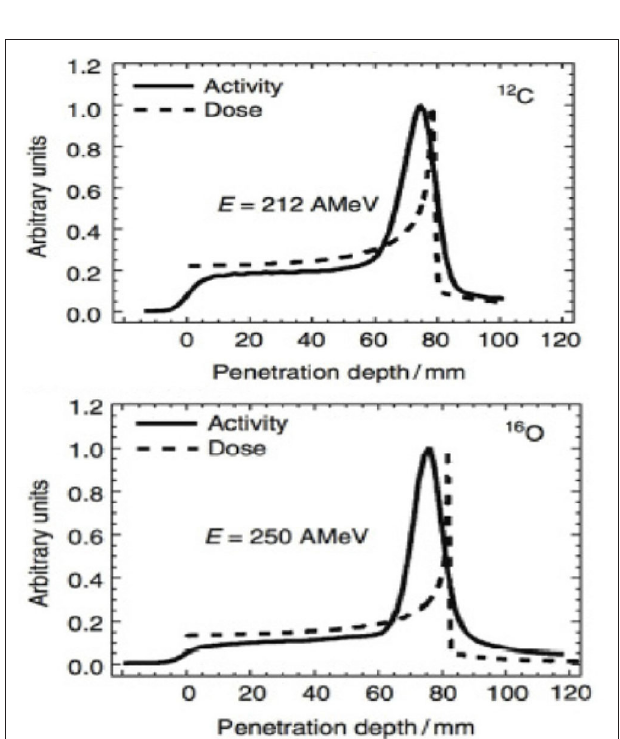
FIGURE 2 | Measured PET activity in PMMA phantoms irradiated at GSI with carbon or oxygen ions, showing the shift between activity and dose peak (measurements from Ref.